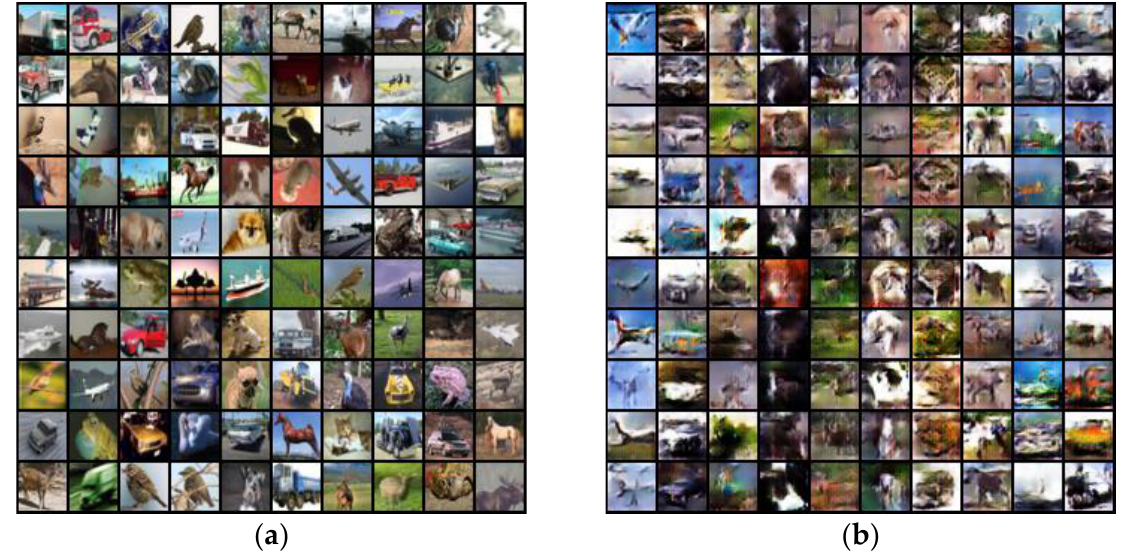
Figure 8. (a). some actual samples from the CIFAR-10 dataset. (b). artificial samples of CIFAR-10 Figure 8. ( a ) some actual samples from the CIFAR-10 dataset. ( b ) artificial samples of CIFAR-10 generated by the image generation model. generated by the image generation